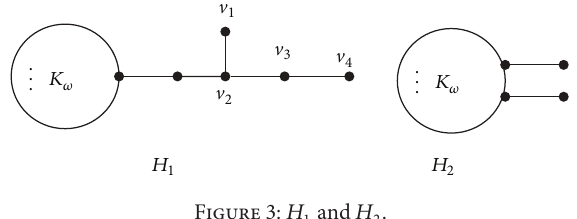
Figure 3: 𝐻 1 and 𝐻 2 .